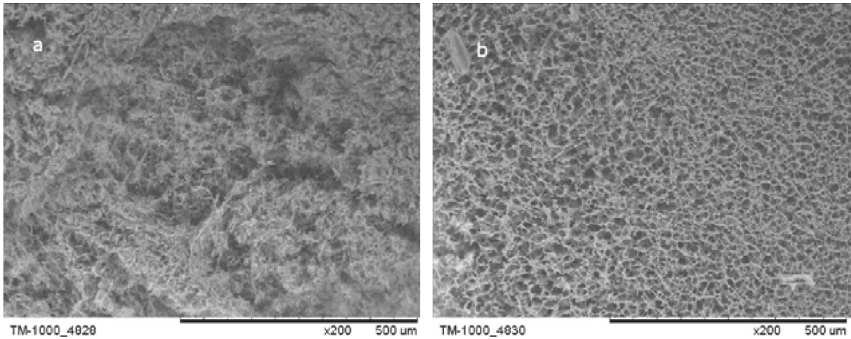
Figure 9: SEM images for AA/CS hydrogel at ratios: (a) 50 and (b) 5. Table 3: pH of polymers in